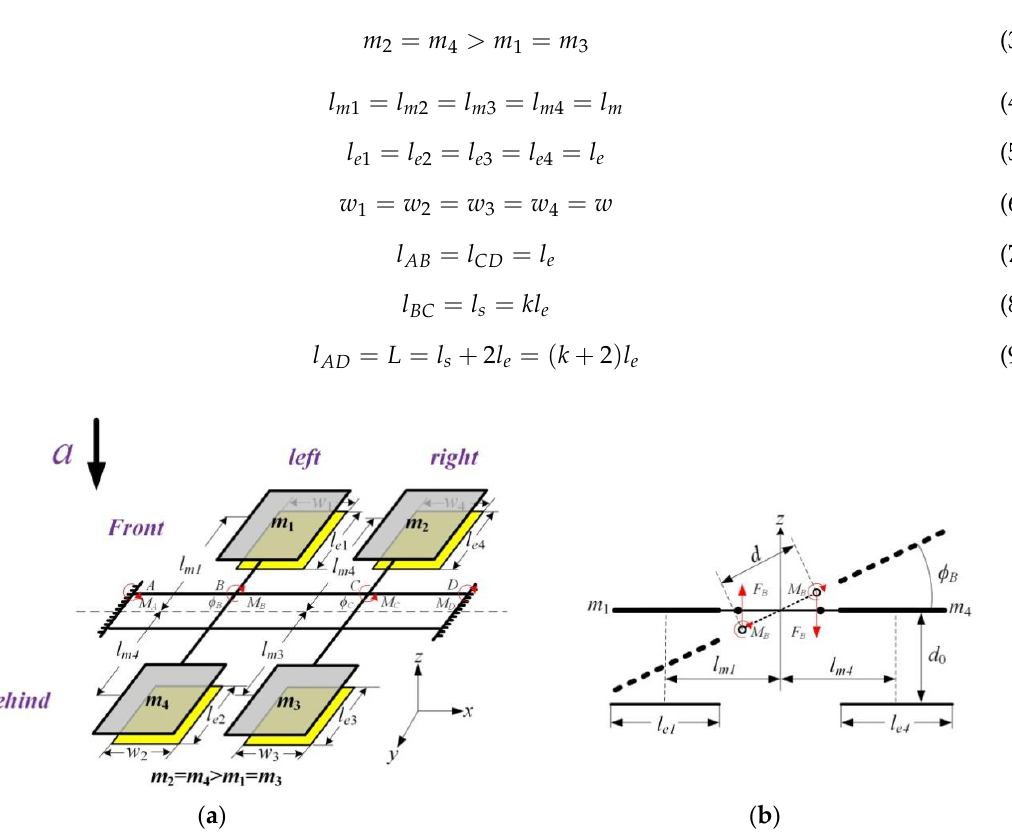
Figure 5. Mathematical model of double differential torsional capacitive accelerometer based on double-beam: ( a ) Torque model of the front torsional beam; ( b ) Mechanical model of the left torsional structure.